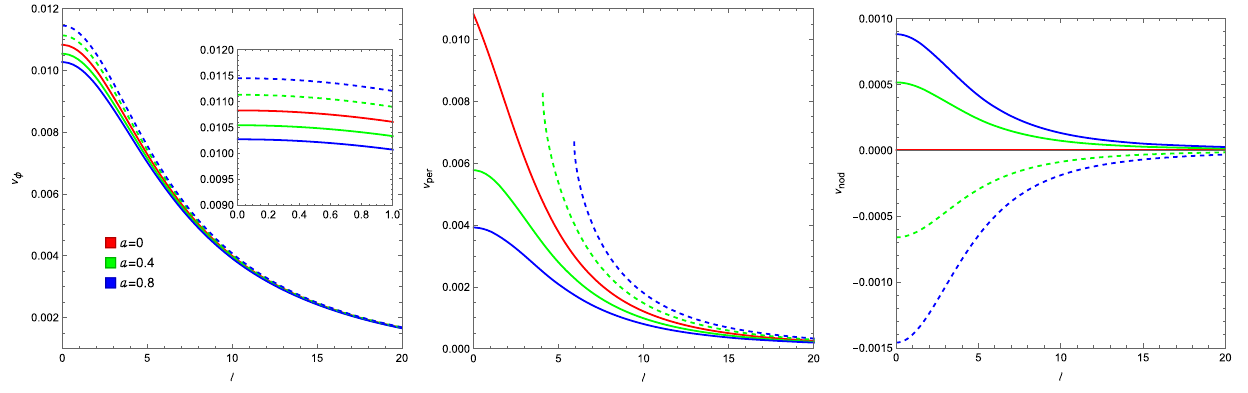
Fig. 2 Plots of the azimuthal epicyclic frequency ν φ (left panel), the periastron precession frequency ν per (middle panel) and the nodal pre- cession frequency ν nod (right panel) of prograde (solid lines) and retro- grade (dashed lines) orbits at ¯ r = 6 as a function of (cid:5) for a = 0 (red lines), a = 0 . 4 (green lines) and a = 0 . 8 (blue lines) in the rotating